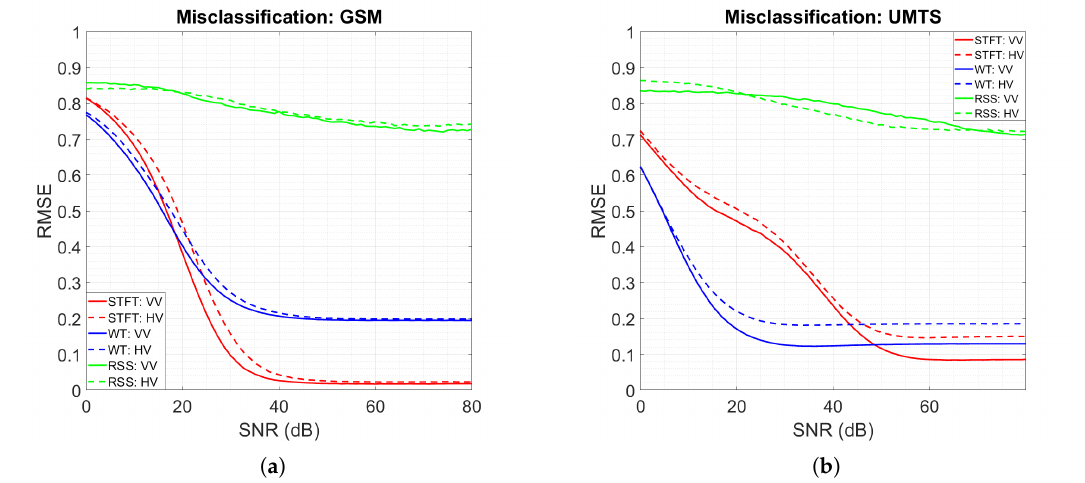
Figure 6. Misclassification of the W K NN as a function of varying SNR for both GSM and UMTS non-cooperative emissions. ( a ) GSM, ( b )